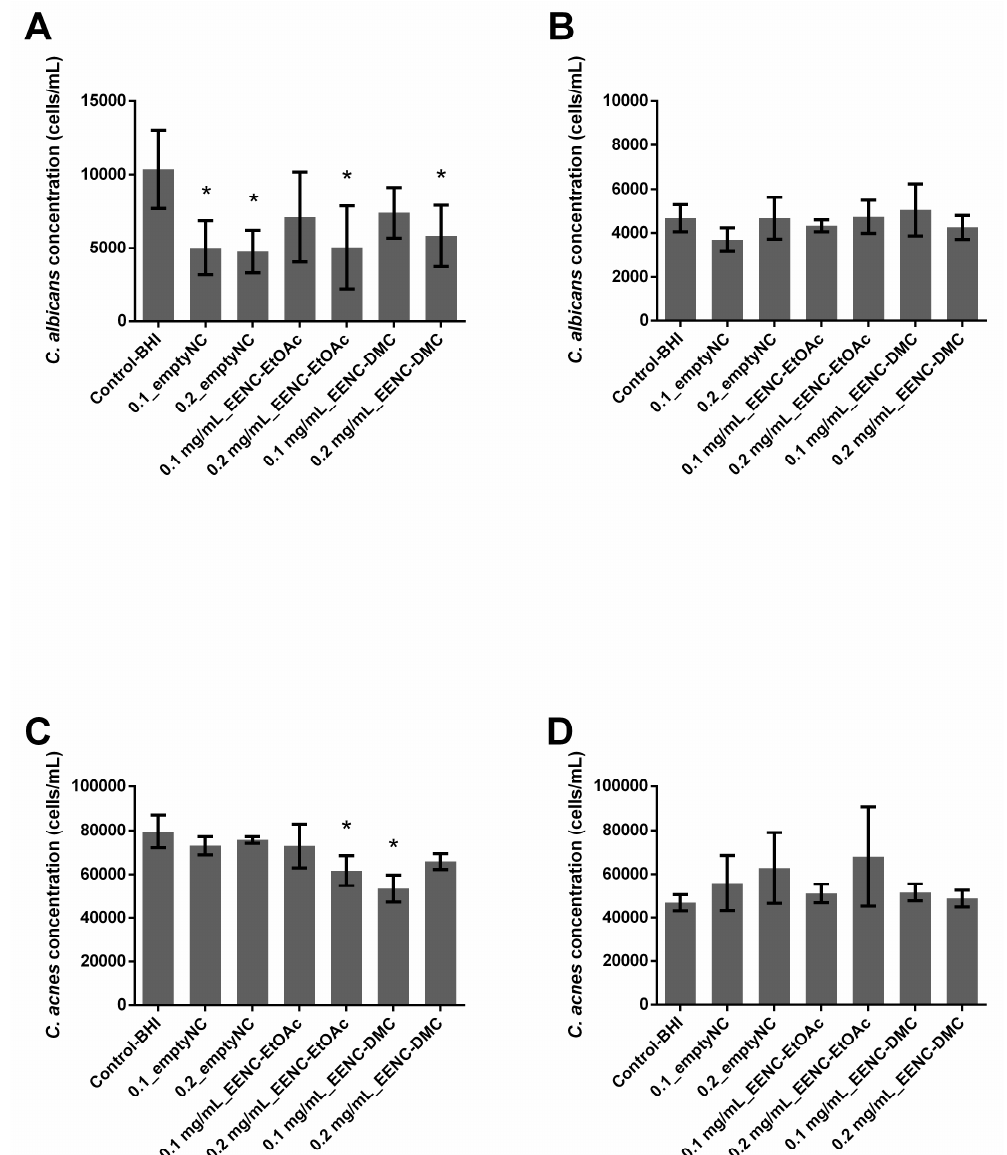
Figure 3. Ability of Arthrospira fusiformis extracts encapsulated in alginate nanocarriers to prevent biofilm formation. Single-species biofilms ( C. albicans ) ( A ); C. albicans concentration obtained in